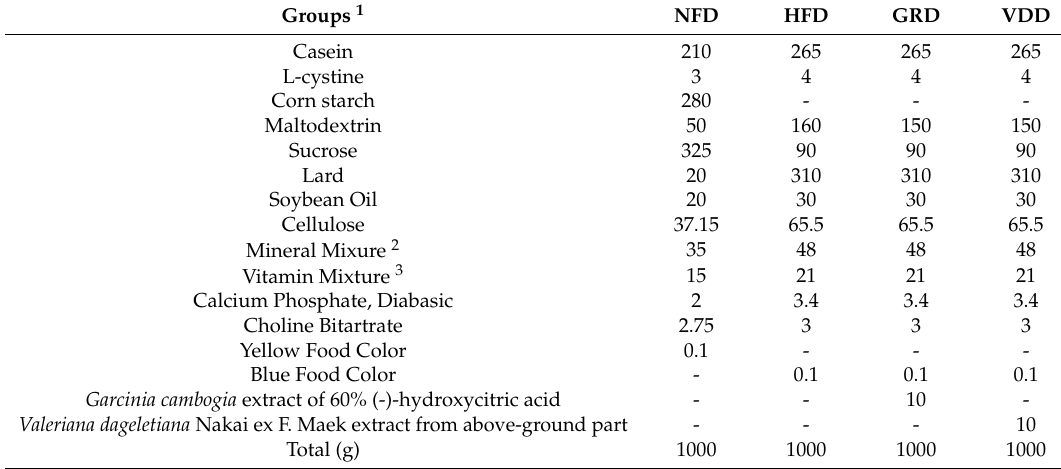
Table 1. Compositions of experimental diets